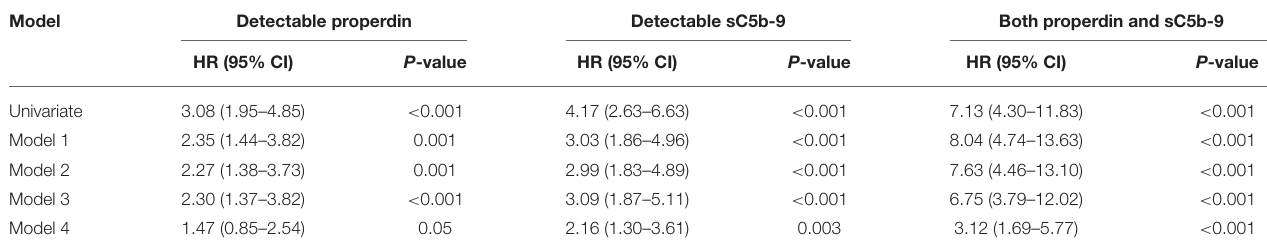
TABLE 2 | Association of detectable urinary properdin and detectable urinary sC5b-9 with graft failure in renal transplant recipients. Model